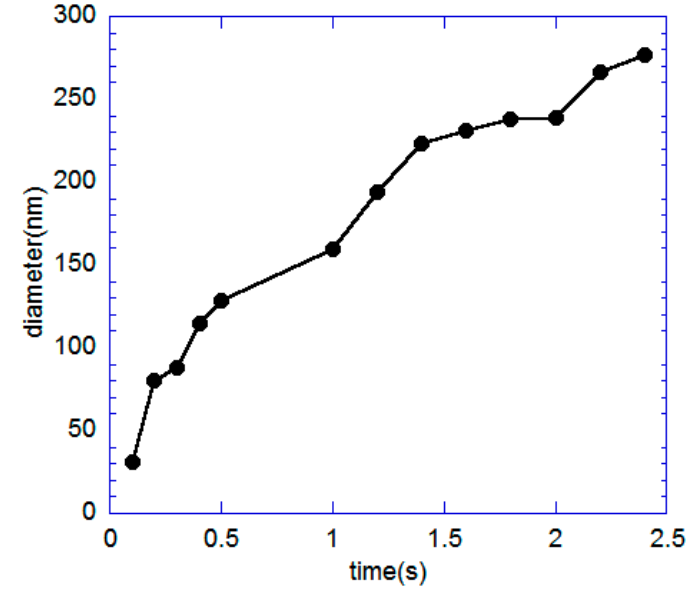
Figure 6. The diameter of the nanohole with the change of milling time.